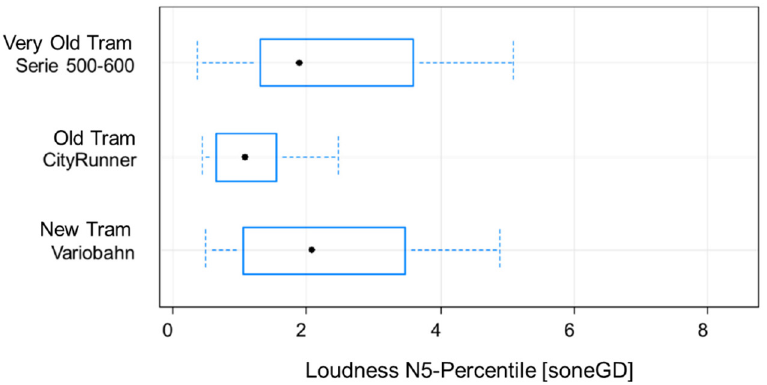
Figure 10. Loudness N5-Percentile in [soneGD] over all measuring points subdivided into “New Tram (Variobahn)”, “Old Tram (CityRunner)” and “Very Old Tram (Series 500/600)”.